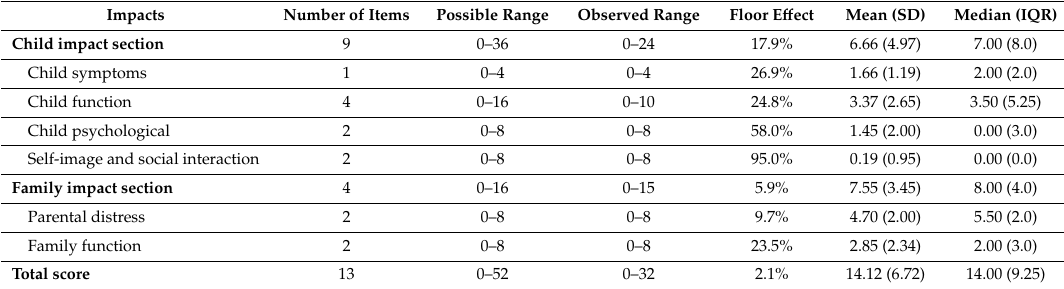
Table 4. Descriptive statistic pertaining to ECOHIS